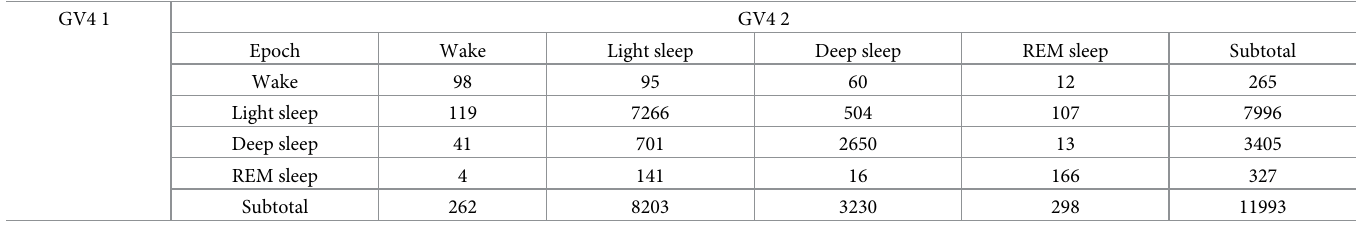
Table 2. Confusion matrix (intra-device agreement).